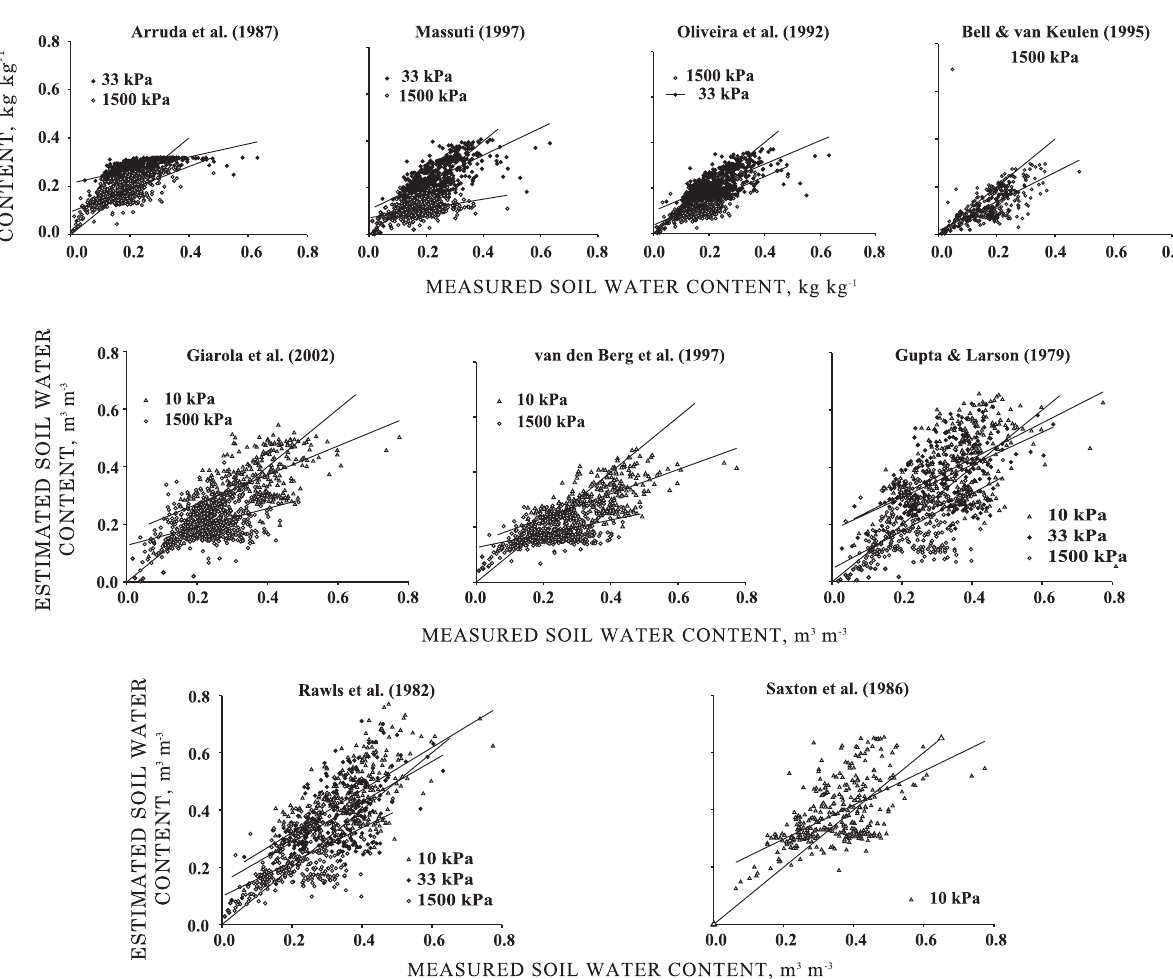
Figure 3. Comparison between soil water content estimated from published pedofunctions (Table 1: Arruda et al., 1987; Giarola et al., 2002; Masutti, 1997; Oliveira et al., 2002; van den Berg et al., 1997), based on soils from Brazil and of tropical climate, and from published pedofunctions (Table 1: Bell & van Keulen, 1995; Gupta & Larson, 1979; Rawls et al., 1982; and Saxton et al., 1986), based on soils from México and USA, and soil water content measured in soils of Rio Grande do Sul. The straight line is the 1:1